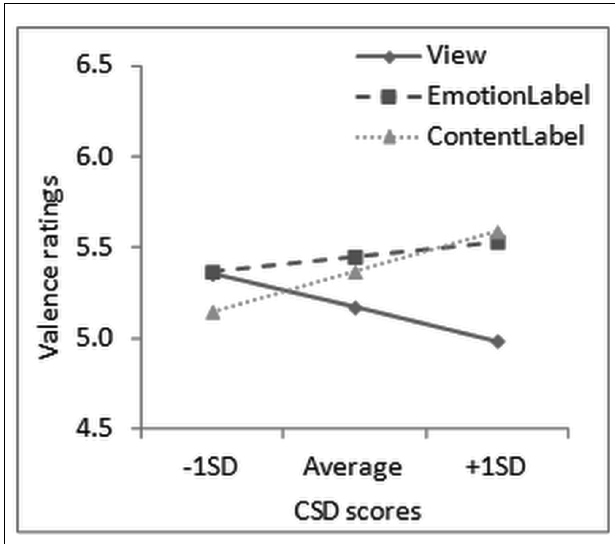
FIGURE 2 | Interaction ofTask with habitual symptom reporting scores for valence ratings after each trial of theAffect Labeling task. CSD = Checklist for Symptoms in Daily Life.